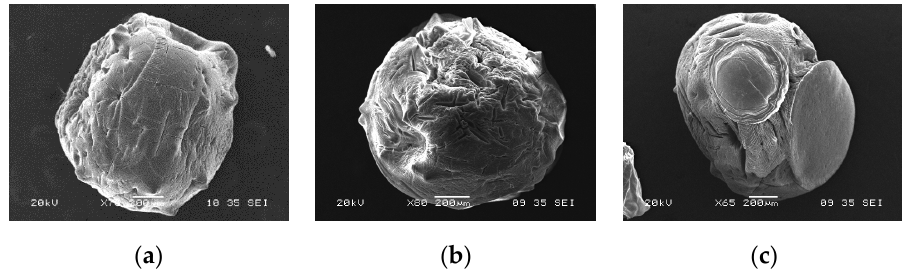
Figure 5. SEM images of CA beads: ( a ) before adsorption; ( b ) after adsorption at 100 ppm Cd 2+ and ( c ) after adsorption at 100 ppm Ni 2+ .